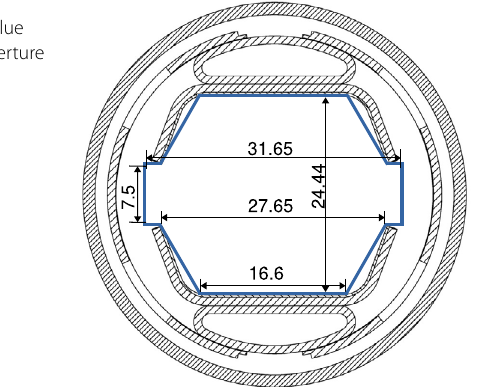
Figure 2 Cross section of FCC–hh beam screen, adapted from [19], values are given in mm. The blue line displays the implementation used for the aperture